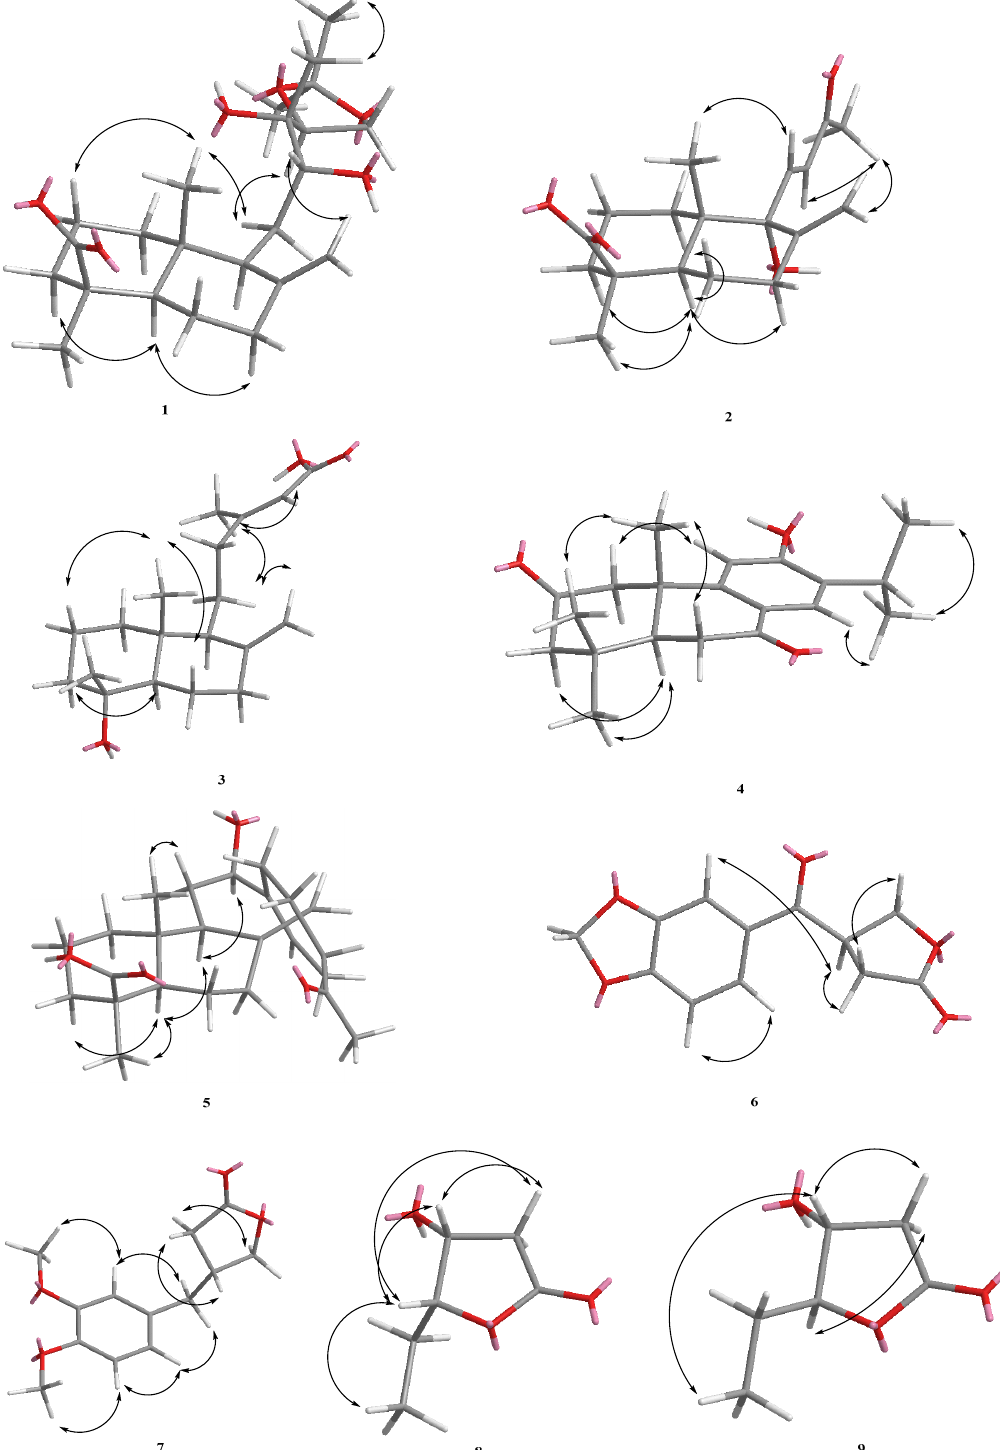
Figure 2. Major NOESY ( ↔ ) contacts of 1 ‒ 9 .